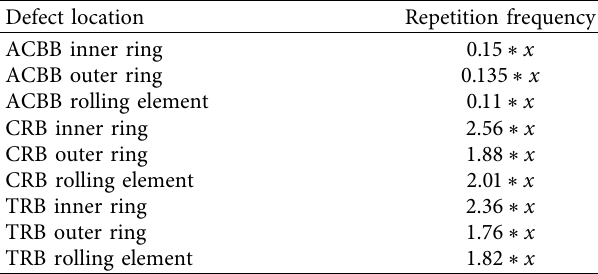
Table 3: Bearings’ defect